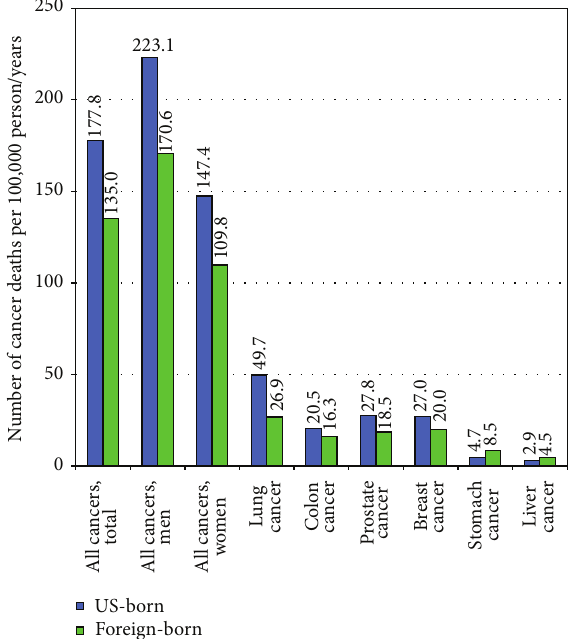
Figure 3: Site-specific US cancer mortality rates by nativity/immigrant status: The US National Longitudinal Mortality Study, 1980–1998 ( 𝑁 = 304, 594 ). Mortality rates are age-adjusted to the 2000 US standard population. Differences in mortality rates between US- and foreign- born individuals were statistically significant at the 0.05 level. Source: updated analysis of data presented in